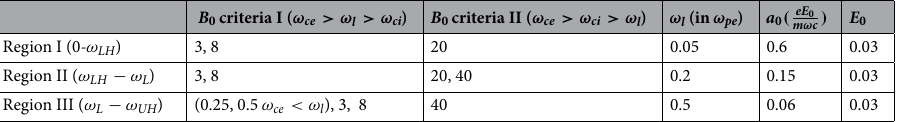
Table 1. Details of various simulation runs used in this study based on different regions of X-mode shown in Fig. 1.